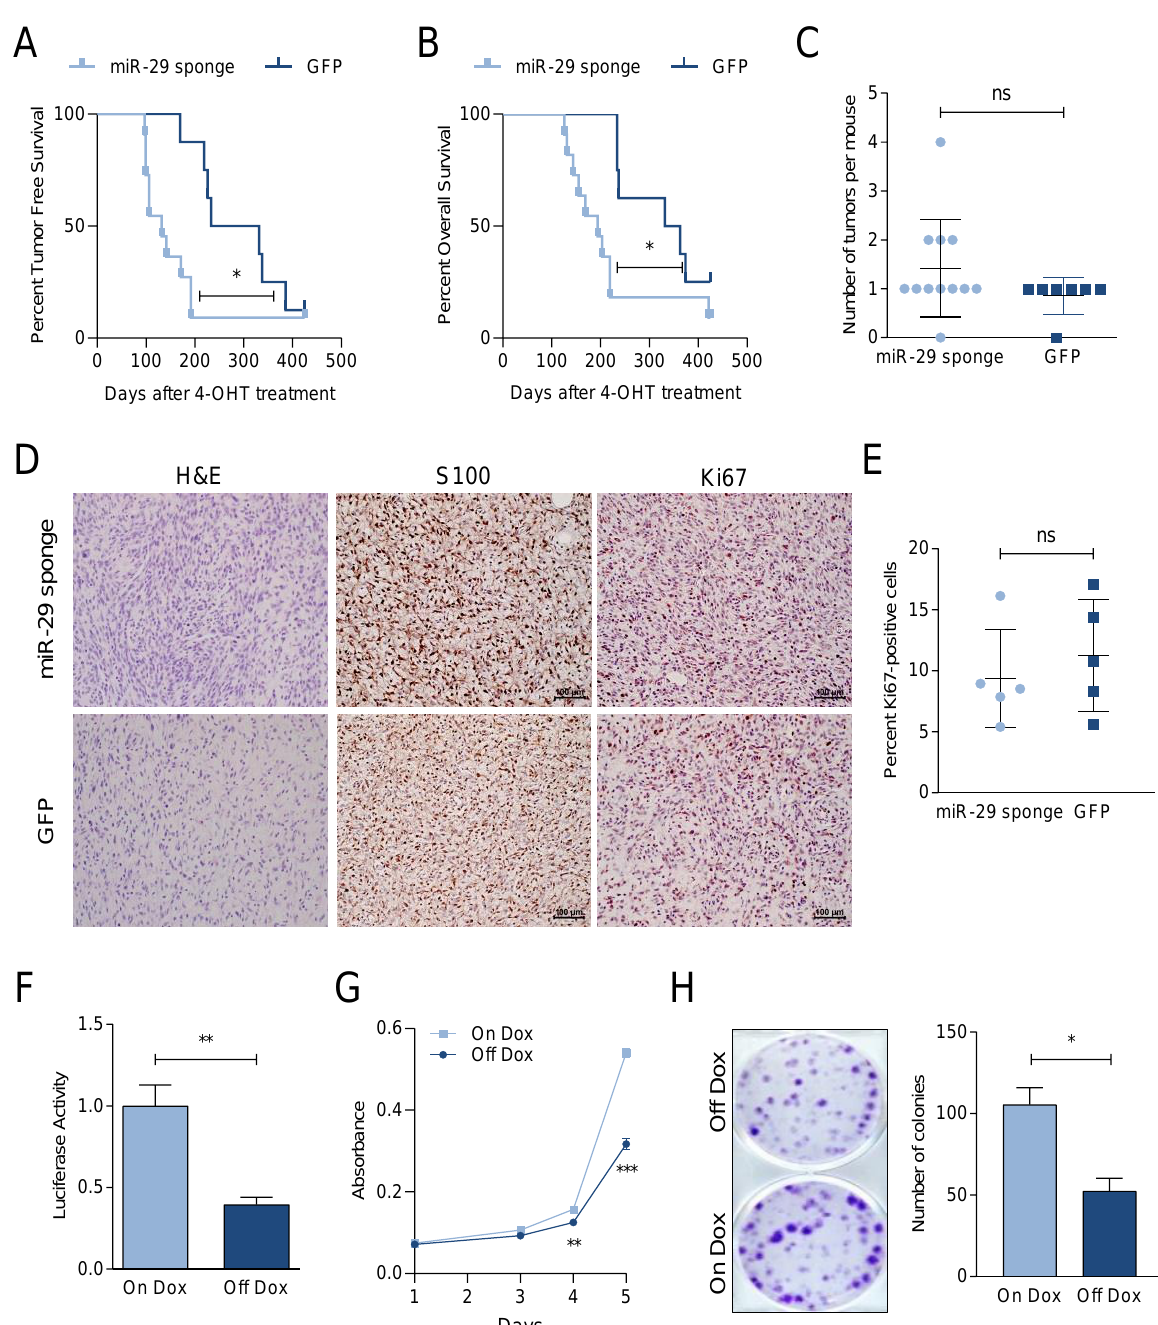
Figure 2. miR-29 inactivation promotes melanoma formation. ( A , B ) Kaplan–Meier curves comparing the tumor free sur-